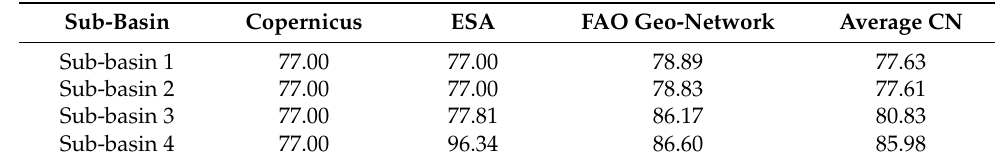
Figure 9. ( a ) Location of the four sub-basins. ( b ) Discharge hydrograph resulting from the hydrological modelling with a return period of 10 years. Table 2. Table of CN values computed for each sub-basin and for each source of soil cover map.